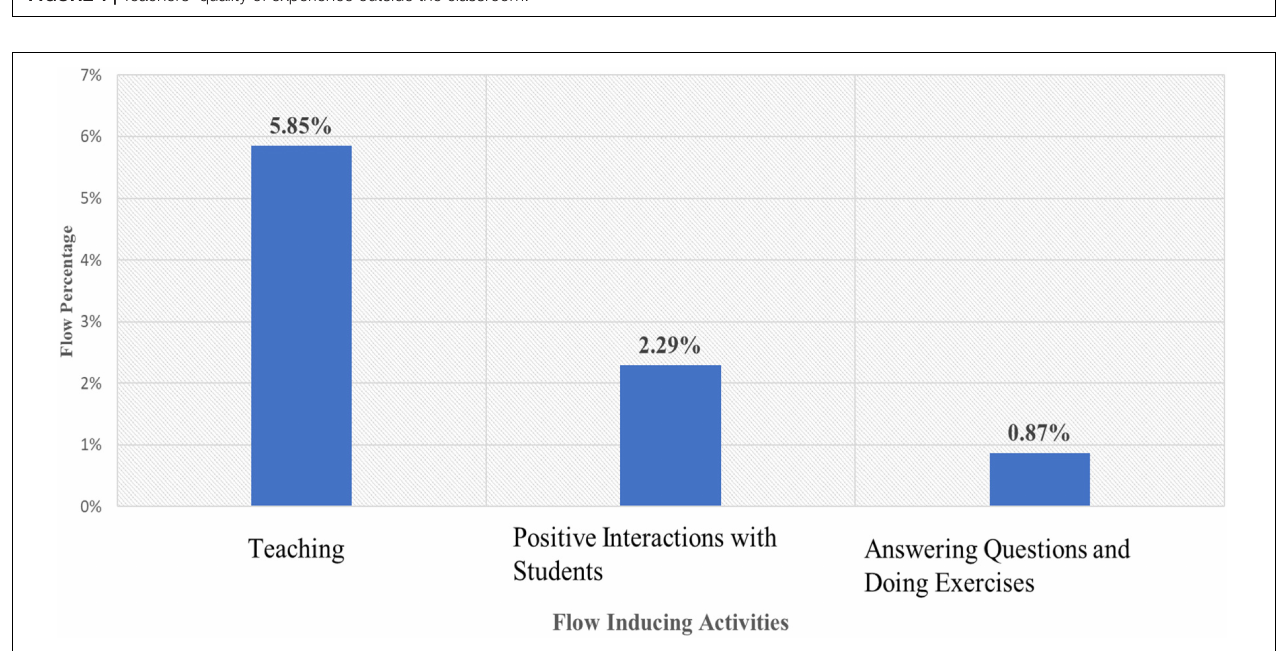
FIGURE 1 | Teachers’ quality of experience outside the classroom.